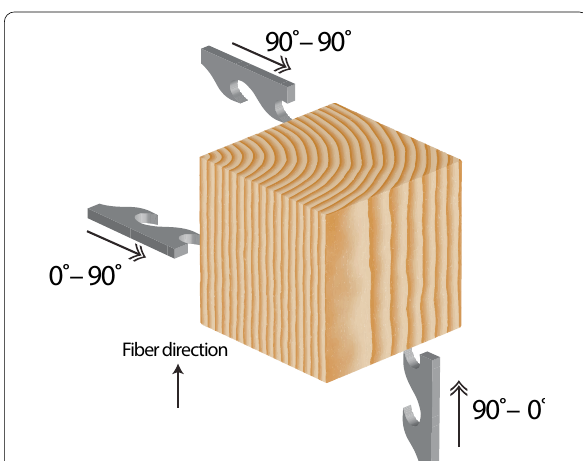
Fig. 5 Definition of cutting directions. Cutting force tests were made in the 90º–90º cutting direction, i.e. the cutting edge and the feeding direction were 90º to the longitudinal fibre direction of the wood